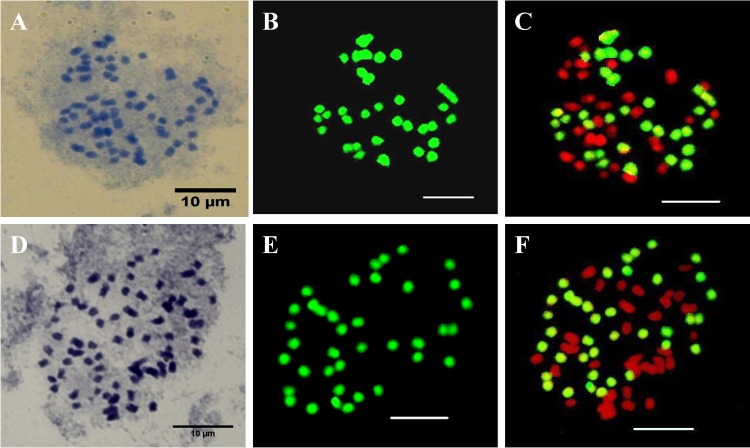
GISH of somatic metaphase chromosomes from intergeneric hybrids between Ascocenda John De Biase ‘Blue’ (♀) and Phalaenopsis Chih Shang's Stripes (♂).Giemsa-stained chromosomes before GISH (A, D) and after GISH using total DNA from Phalaenopsis Chih Shang's Stripes, as revealed with FITC (B, E). A composite image of chromosomes counterstained with propidium iodide (red) and showing FITC signals (green) (C, F). Scale bar: 10 μm.